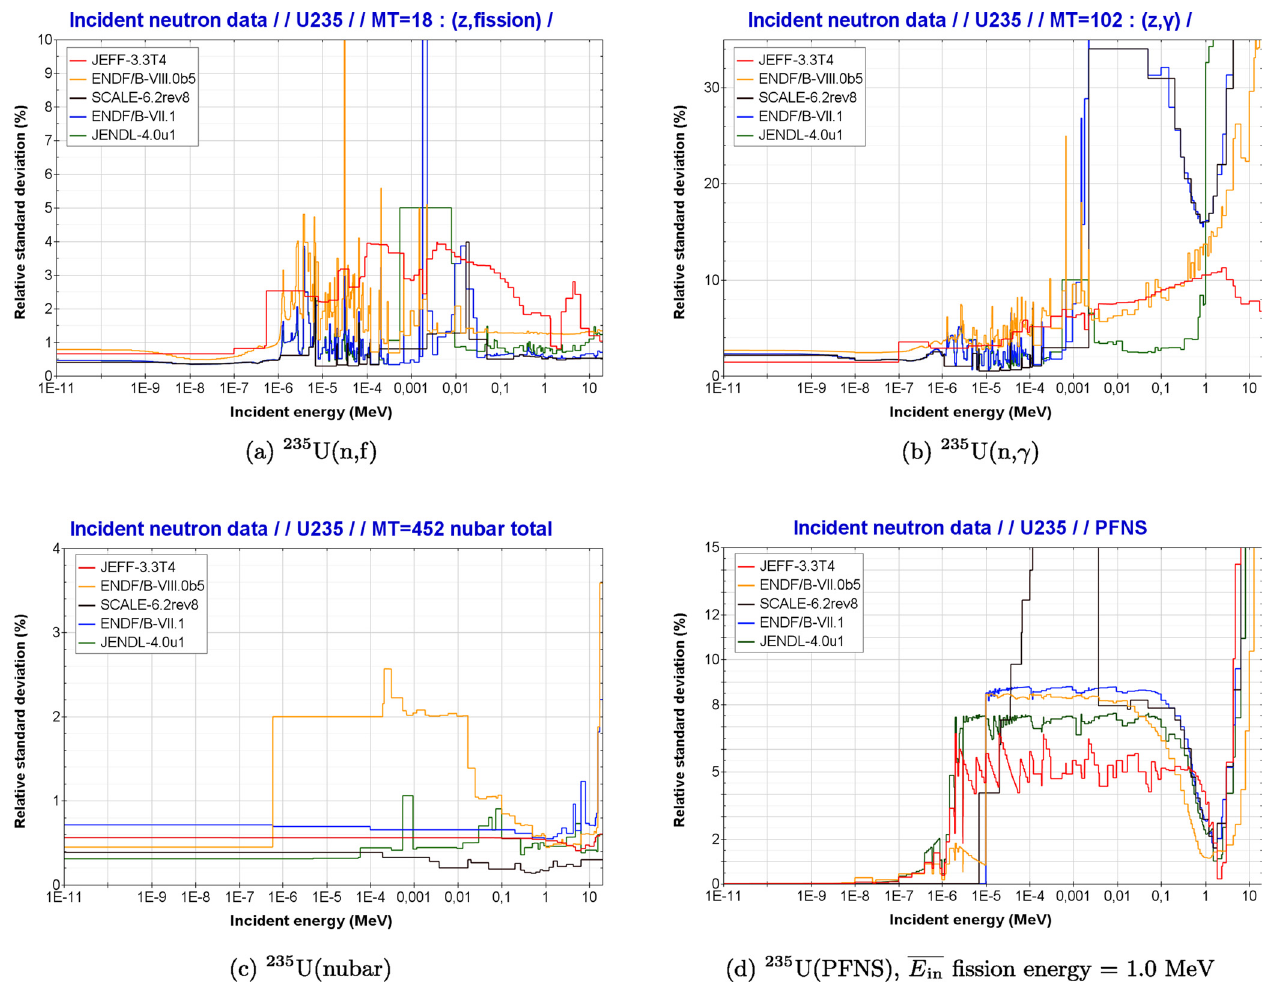
Fig. 1. Relative standard deviation (%) for 235